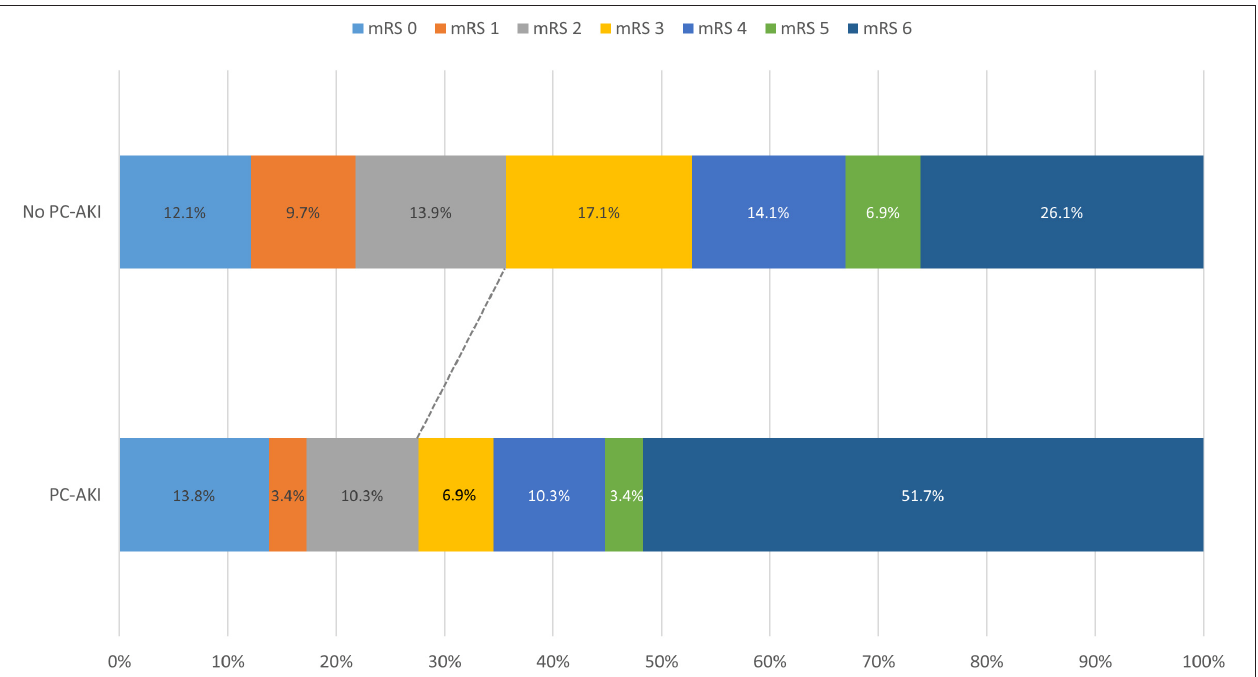
FIGURE 1 | Clinical outcomes of patients with and without PC-AKI. All 1,169 patients were considered. The cutt-off for functional dependence was set at a mRS of >